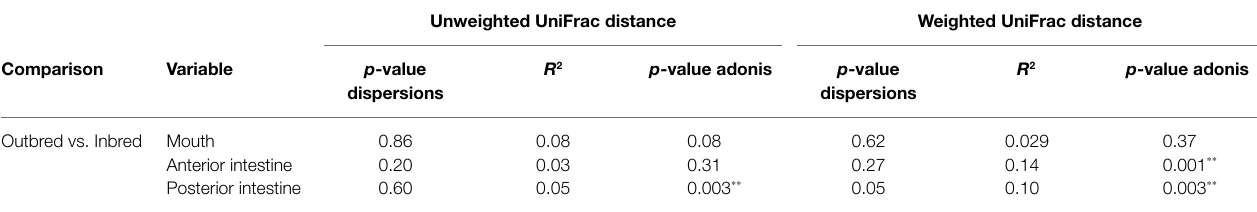
TABLE 3 | Results of the analysis of homogeneity of group dispersions and PERMANOVA using distance (unweighted and weighted UniFrac)